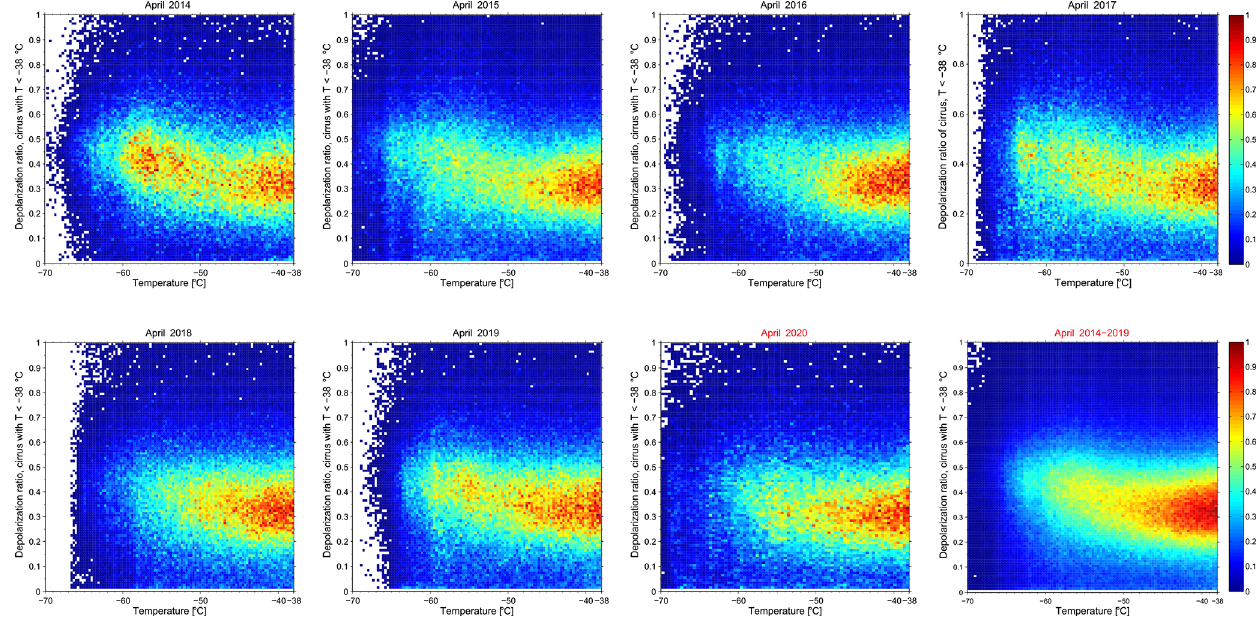
Figure 7. Correlations between the particle linear depolarization ratios (PLDRs) of cirrus clouds and the ambient temperatures derived from the lidar measurements of CALIPSO and GEOS-5 model data, respectively. The color codes are used to visualize the relative number densities of scatter point data, with the maximum number density indicated by 1 in the corresponding color bar for each